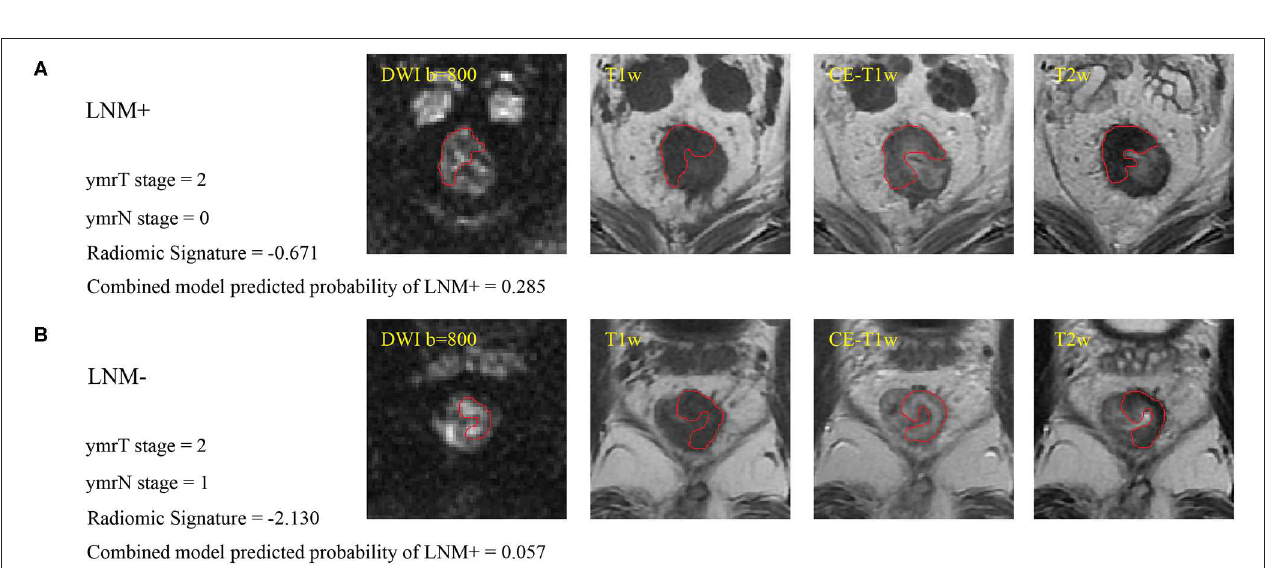
FIGURE 1 | Recruitment pathway for patients in this study. LARC, locally advanced rectal cancer; T1w, T1-weighted; CE-T1w, contrast-enhanced T1-weighted; DWI, diffusion-weighted imaging; MRI, magnetic resonance imaging.